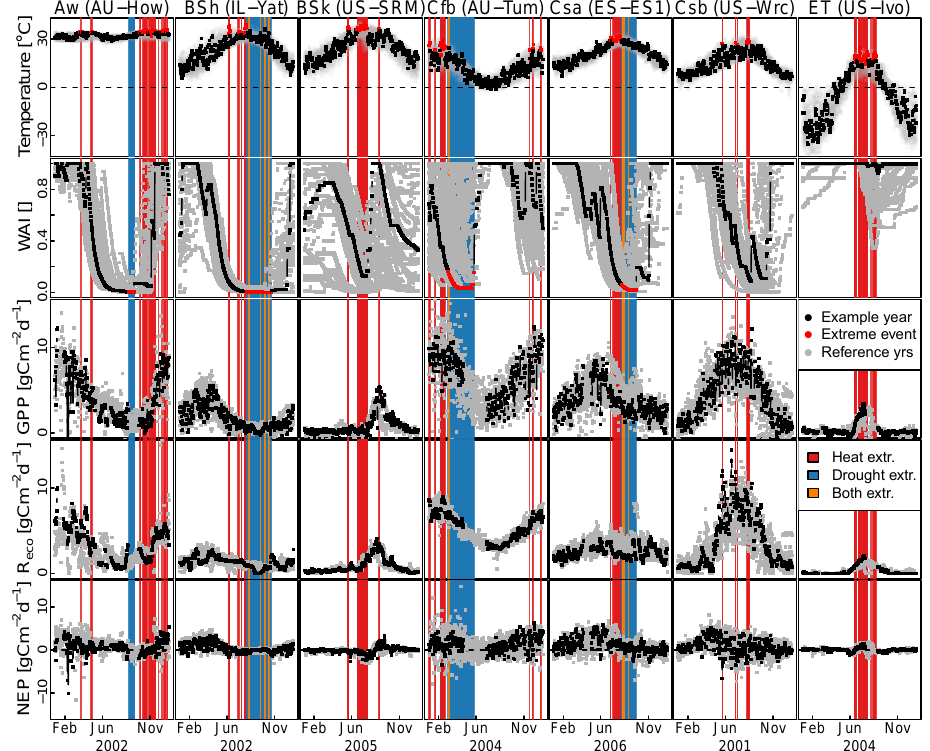
Figure 8. Yearly cycles for climatic forcing variables (air temperature and the water availability index (WAI)) and carbon fluxes (gross primary production (GPP), ecosystem respiration (R eco ) and net ecosystem production (NEP)) for one example site for each different climatic region (i.e., Geiger–Köppen climate class; see Table A2). One example year (black dots) is shown, with various detected extreme events (red dots). Grey dots represent all reference data from other years. Colored backgrounds indicate the different extreme events detected in the example